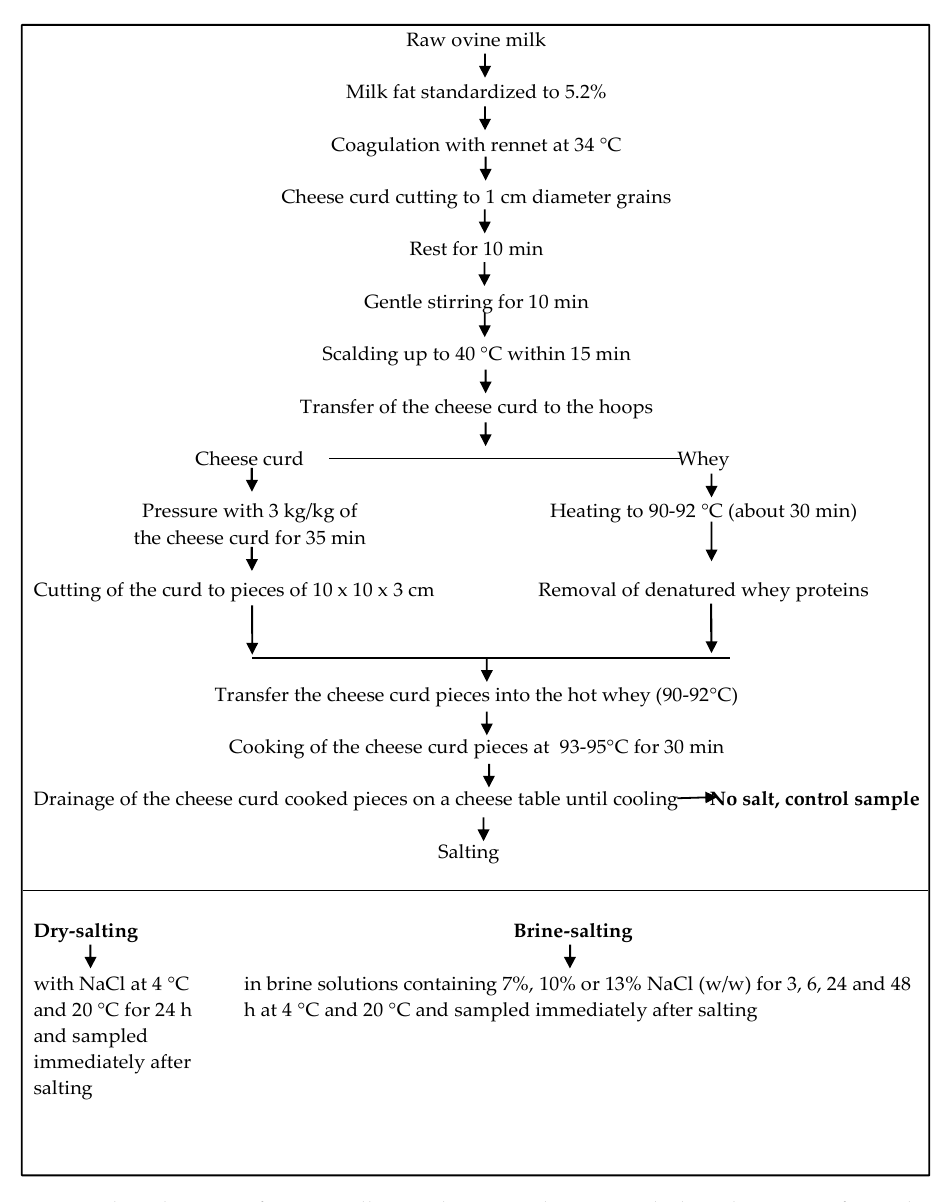
Figure 1. Flow diagram of ovine Halloumi cheese production, including the stages of sampling .